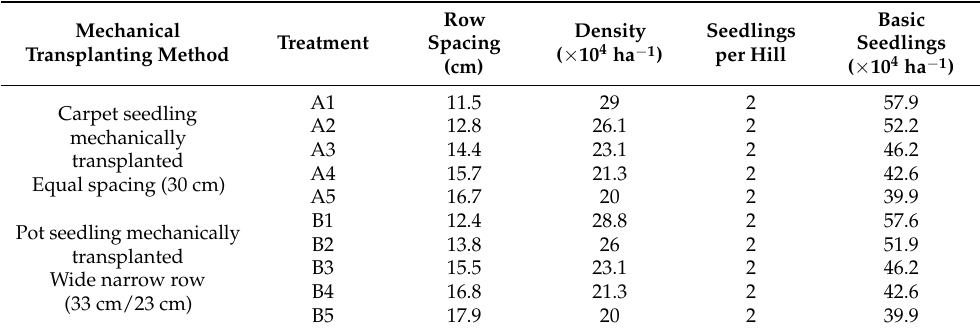
Table 1. Rice transplanting spacing allocation and basic seedling of different mechanical transplanting